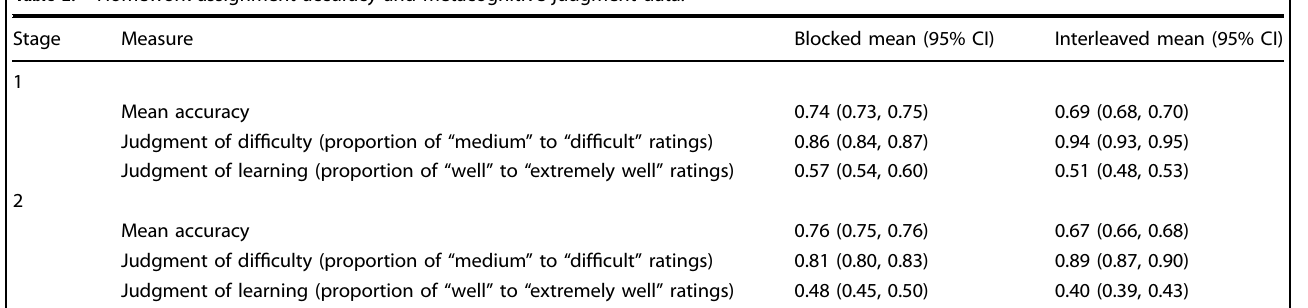
Table 2. Homework assignment accuracy and metacognitive judgment data.